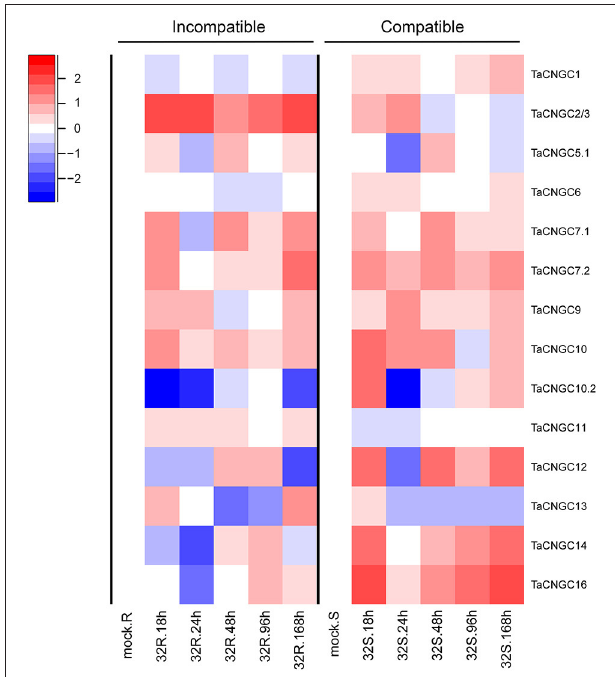
FIGURE 4 | Transcriptional level of TaCNGCs in compatible and incompatible interaction between wheat and Pst . Expression patterns of TaCNGCs were performed with logFC [log (foldchange) 2 ] at 0, 18, 24, 48, 96, and 168 hpi in compatible and incompatible groups by the time series dual RNA-seq data. 32R (right) indicates the incompatible combination, and 32S represents the compatible combination. Blue and red colors indicate down-regulation and up-regulation, respectively. White indicates similar expression patterns as observed with mock